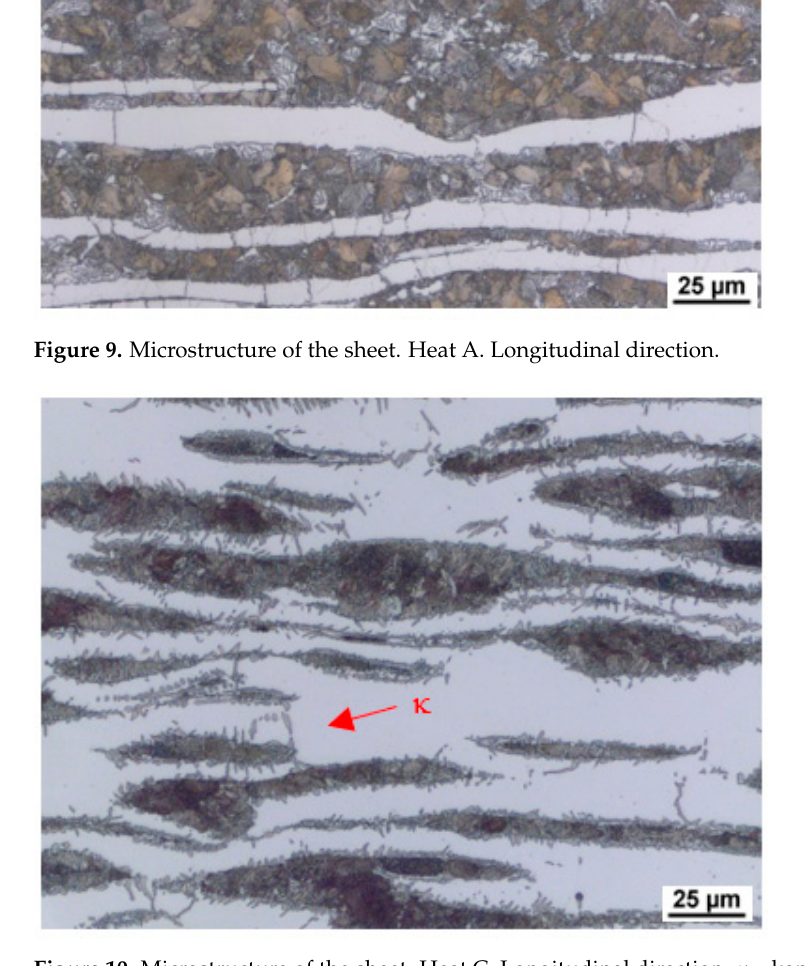
Figure 10. Microstructure of the sheet. Heat C. Longitudinal direction. κ —kappa phase. Table 2. Amount of ferrite in the microstructure—initial state. Ferrite Percentage